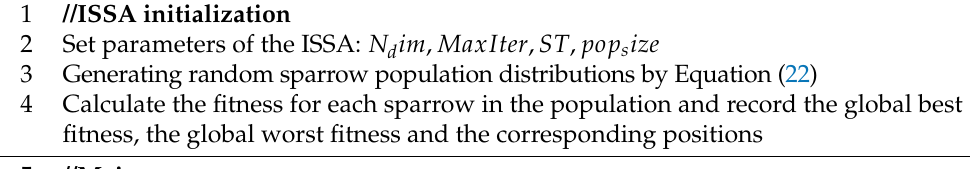
Table 2. Pseudo-code of ISSA